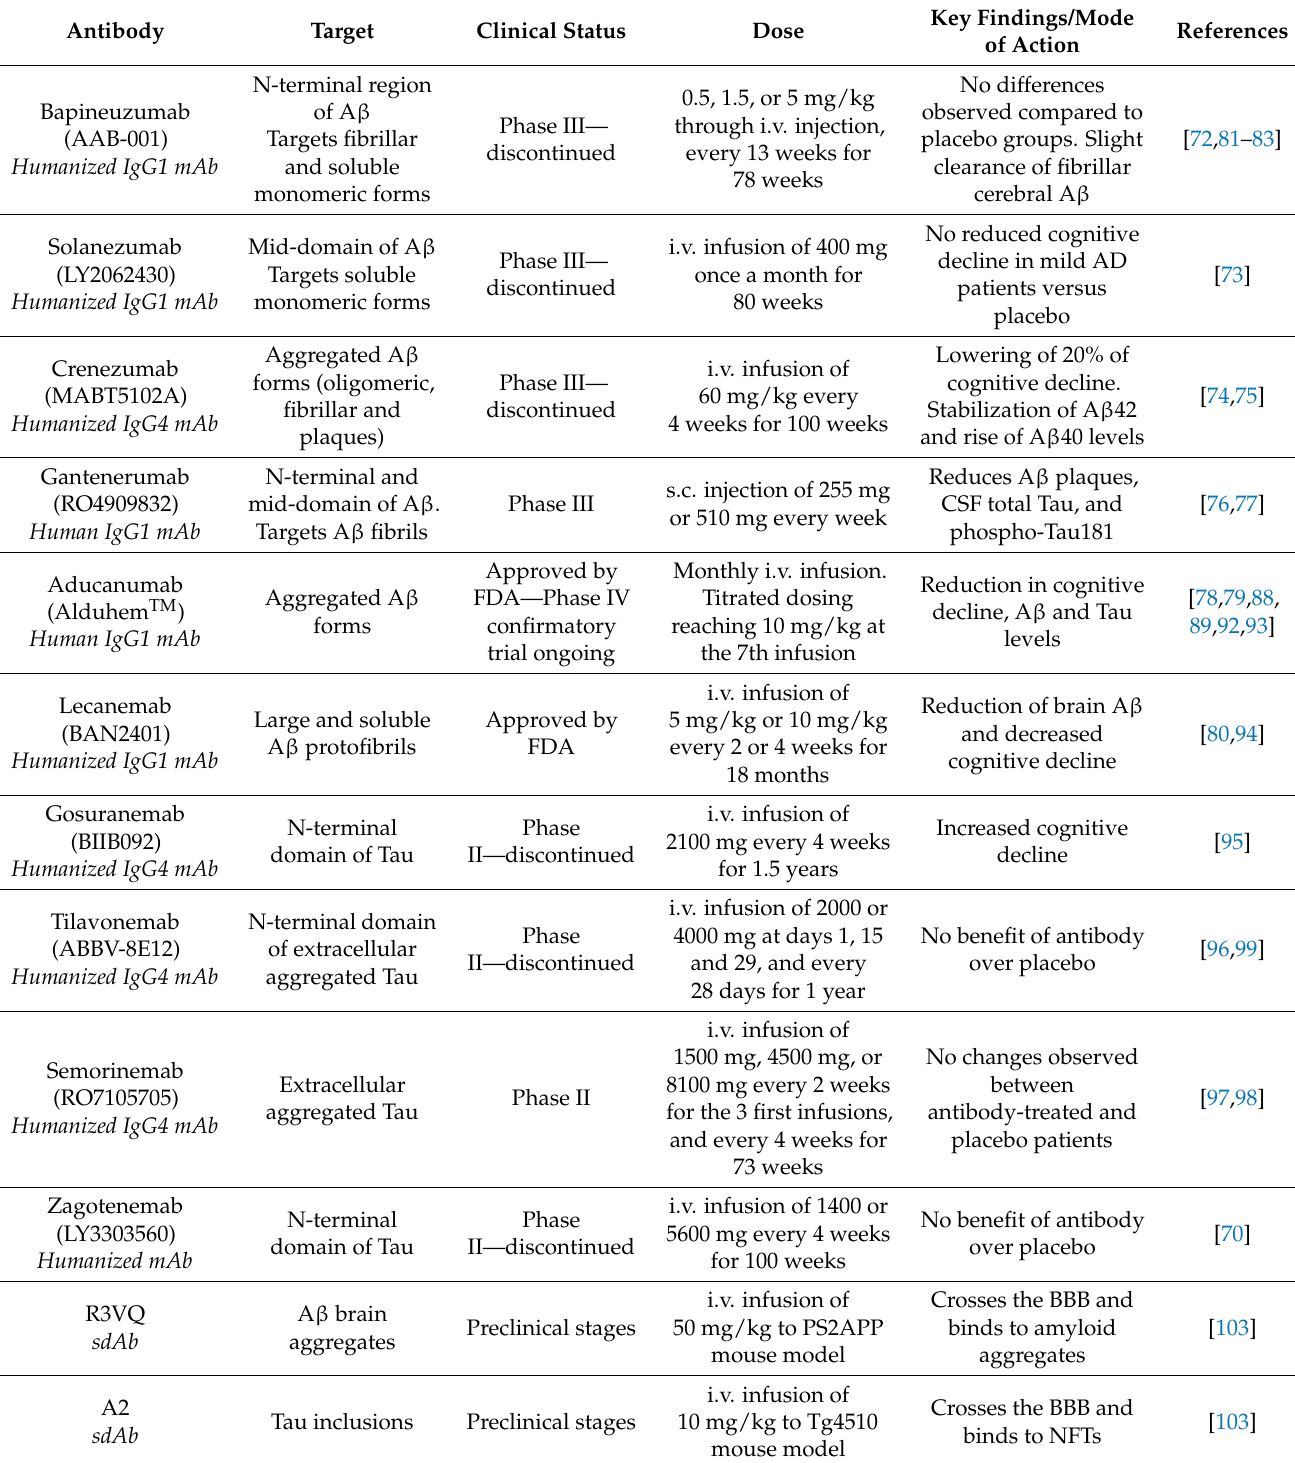
Table 4. Nonexhaustive list of antibodies tested in Alzheimer’s disease